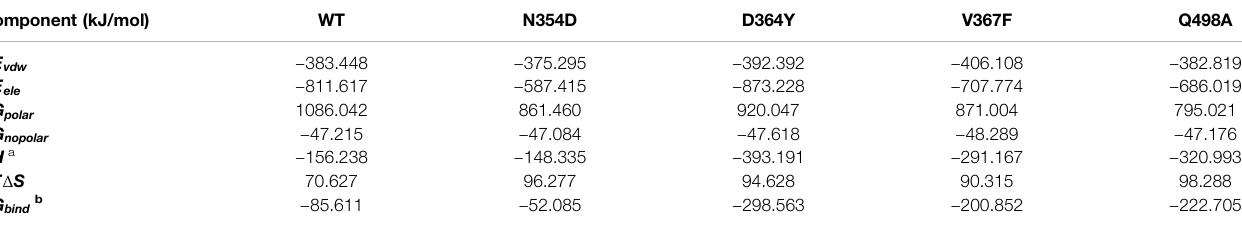
TABLE 2 | Binding free energy components for the ACE2-RBD complex by using the MM-PB/SA method. Component (kJ/mol)